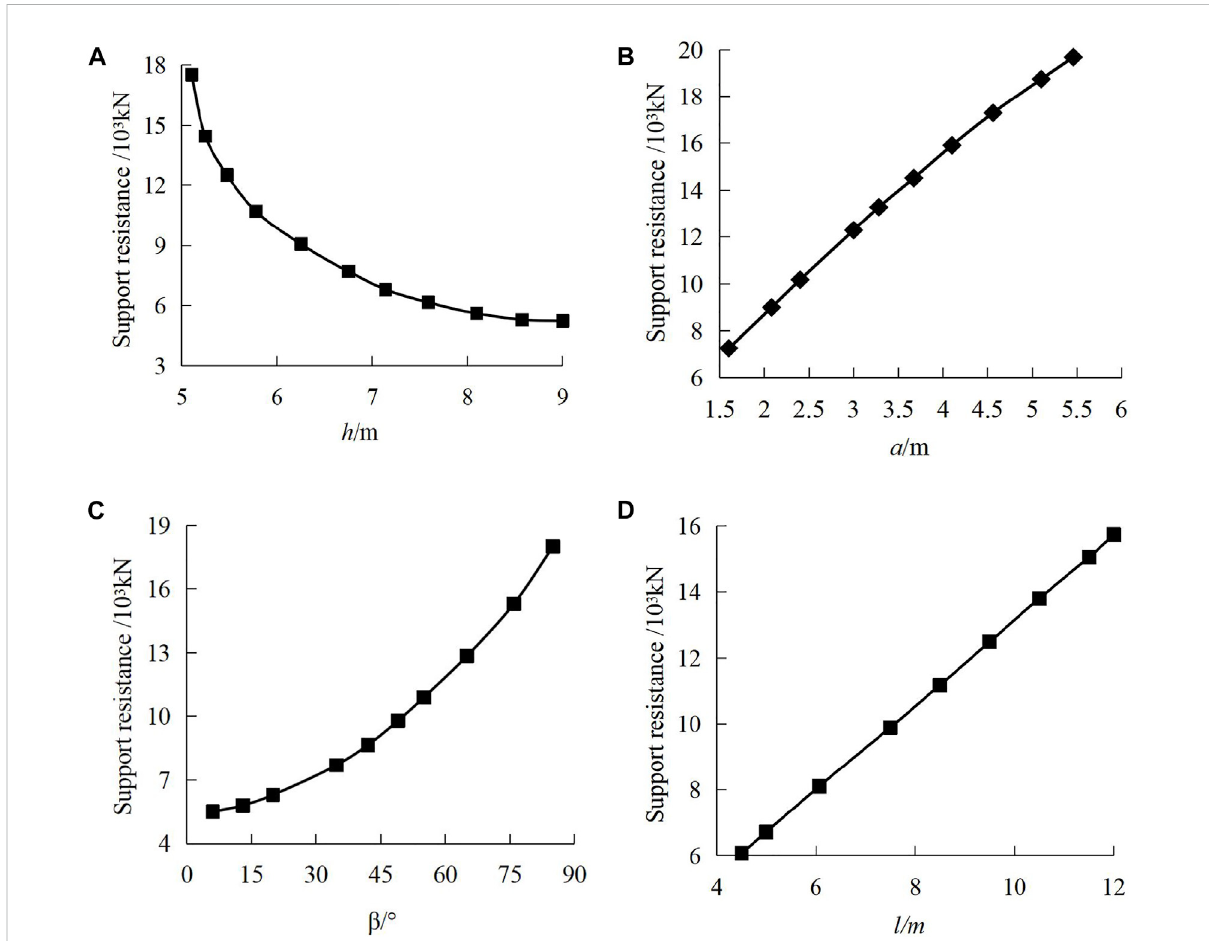
FIGURE 7 Support resistance calculation for three basic loads: (A) rock thickness, (B) crack length, (C) crack dip angle, and (D) weighting interval.